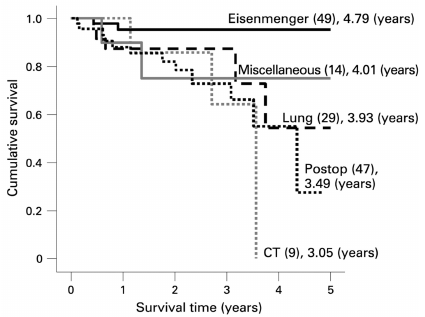
Figure 4. Survival curves for the subgroups within the associated pulmonary arterial hypertension (APAH) group from the UK pulmonary hypertension service. The number in each group (brackets) and the predicted survival out of a possible 5 years is depicted. Note the worse survival for children with post-operative congenital heart disease